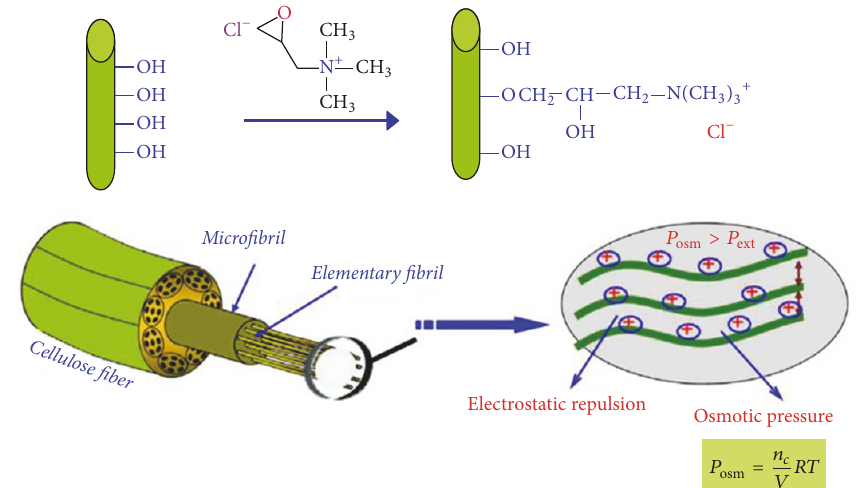
Figure 15: Schematic diagram of cellulose cationization using (2,3-epoxypropyl) trimethylammonium chloride